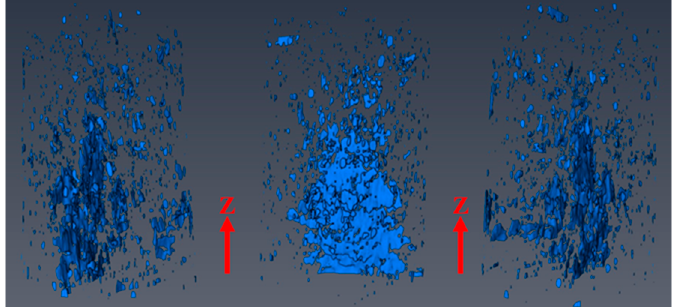
Figure 13. Pore 3D reconstruction results.